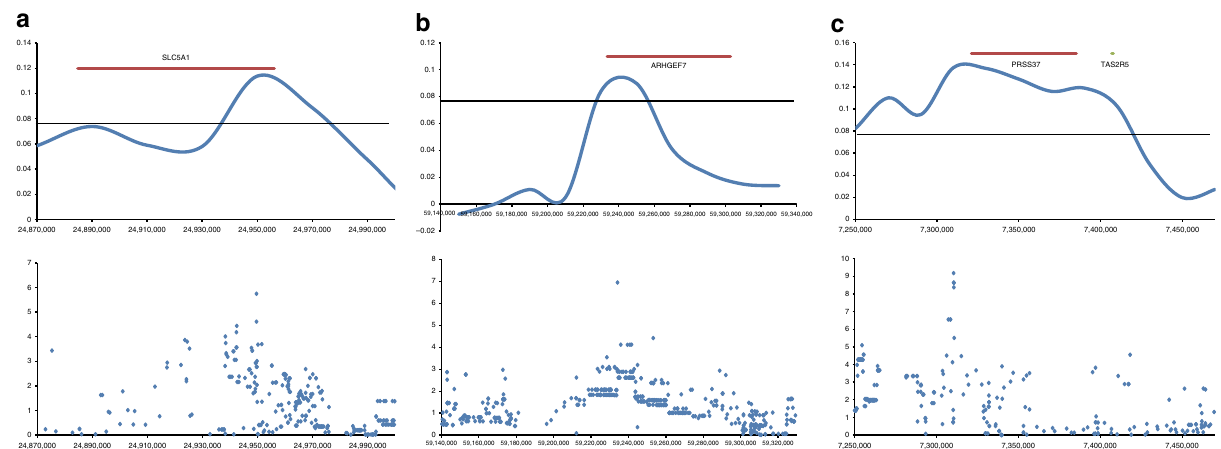
Fig. 4 The result of iHS and PBS2 for three candidate regions. Blue curves indicate PBS2 value, blue dots indicate iHS value. Thick red horizontal line indicates range of gene, and thin black horizontal line gives the threshold.